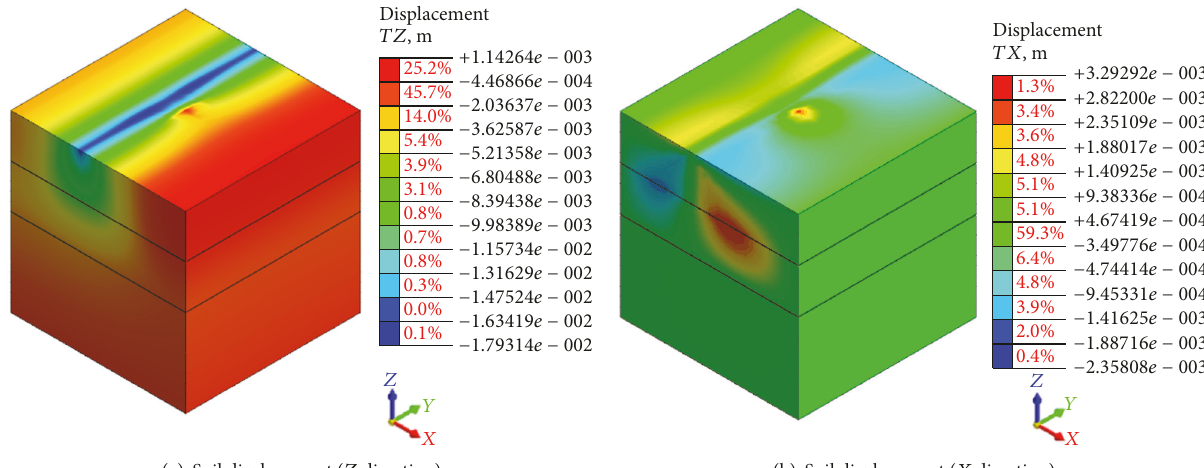
Figure 3: Soil displacement under 100 kPa of stacking